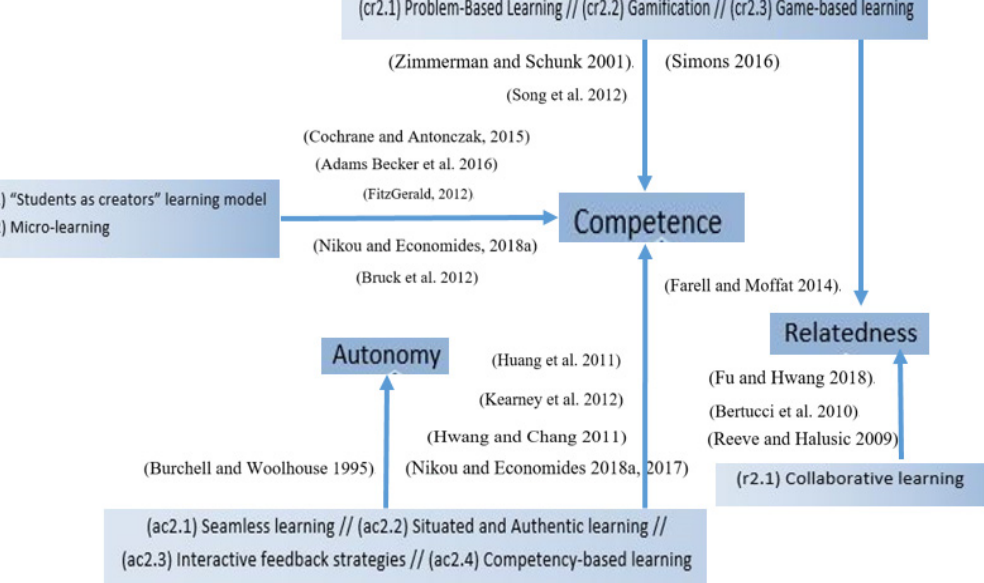
Figure 2. Motivation supportive pedagogies.